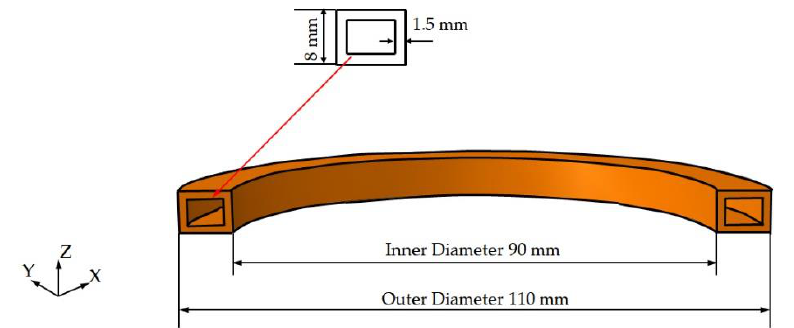
Figure 4. Schematic diagram of the single coil.